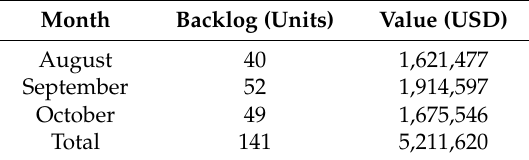
Table 4. The sales backlog (August 2015 to October 2015). Month